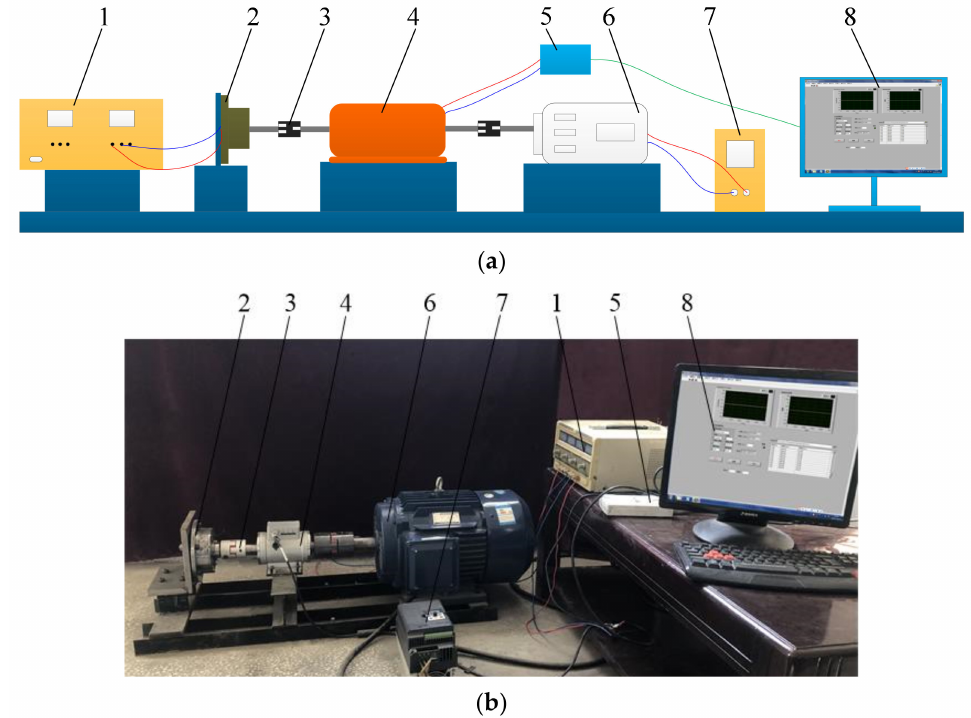
Figure 12. Experimental test rig. ( a ) Schematic diagram and ( b ) test rig. (1) Power supply, (2) MR brake, (3) coupling, (4) speed torque sensor, (5) acquisition board, (6) three-phase asynchronous AC motor, (7) frequency converter, (8)